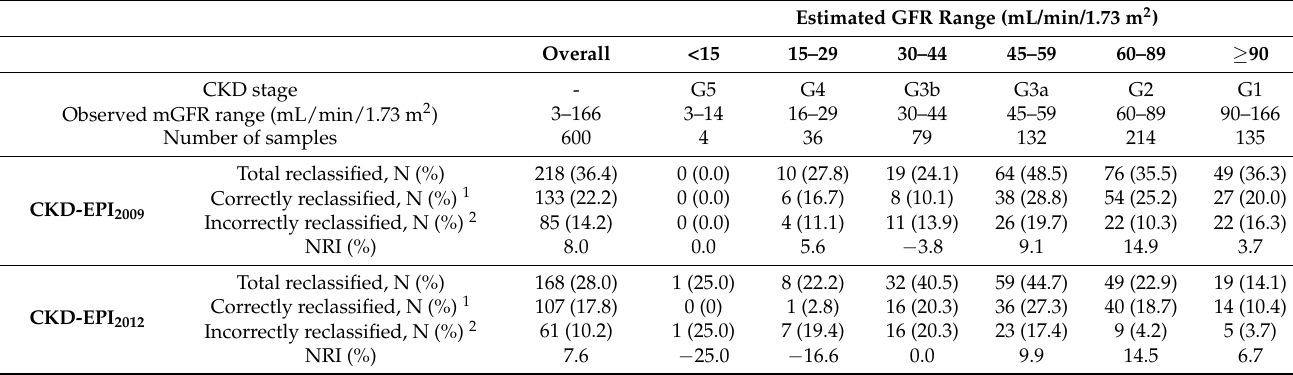
Table 4. Net reclassification by GFR NMR vs. CKD-EPI 2009 or CKD-EPI 2012 in the overall external validation set ( n = 600) and according to eGFR ranges and CKD